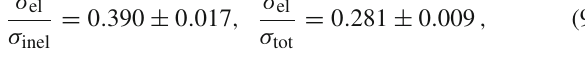
Fig. 4 Overview of elastic ( σ el ), inelastic ( σ inel ), total ( σ tot ) cross section for pp and p ¯ p collisions as a function √ s , including TOTEM of measurements over the whole energy range explored by the LHC [1–5,7,8,12– 14,17,18,21,23,24,28,30,32]. Uncertainty band on theoretical models and/or fits are as described in the legend. The continuous black lines (lower for pp, upper for p ¯ p) represent the best fits of the total cross section data by the COMPETE collaboration [26]. The dashed line results from a fit of the elastic cross section data. The dash-dotted lines refer to the inelastic cross section and are obtained as the difference between the continuous and dashed